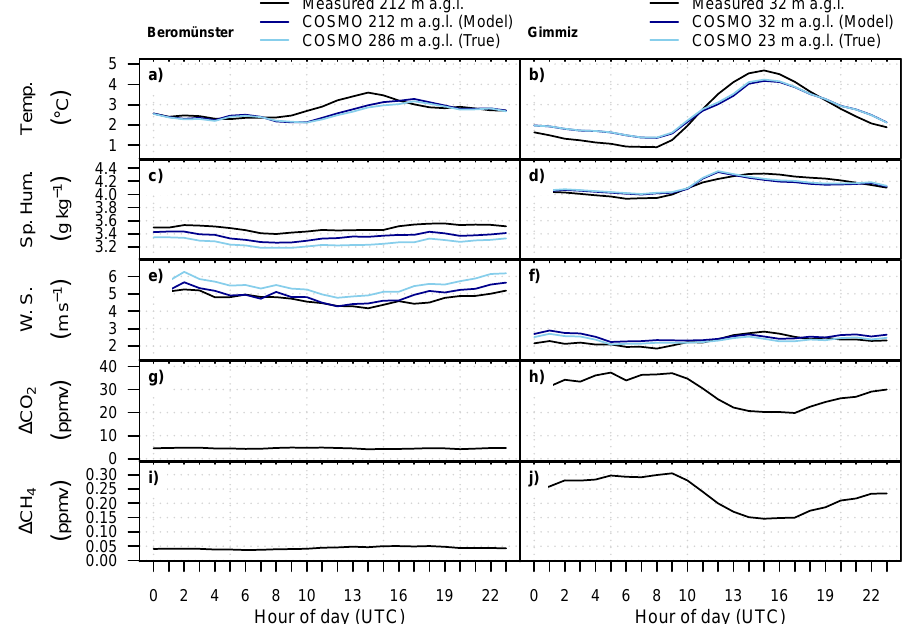
Figure 6. Similar to Fig. 5, the mean diurnal cycles during winter (December 2013–February 2014) at the sites Beromünster and Gimmiz.